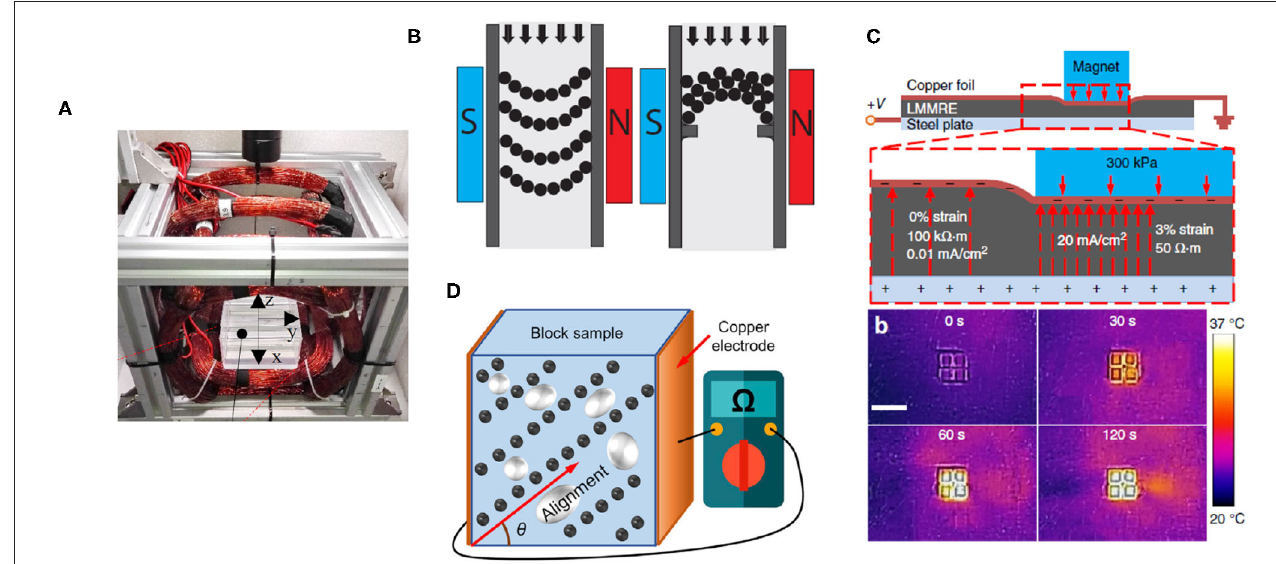
FIGURE 4 | (A) Large, bulky magnetic field generators necessary for the control of small soft robots comprised of MEs (Manamanchaiyaporn et al., 2020), (B) a rigid MRF valve, showing both traditional and jamming designs ( Leps et al., 2020), (C) a magnetically-selected sME-based joule heater (Yun et al., 2019), and (D) an anisotropic hybrid sME with varying resistivity and piezoelectric properties based on the anisotropy angle of the magnetic particles ( Yun et al.,